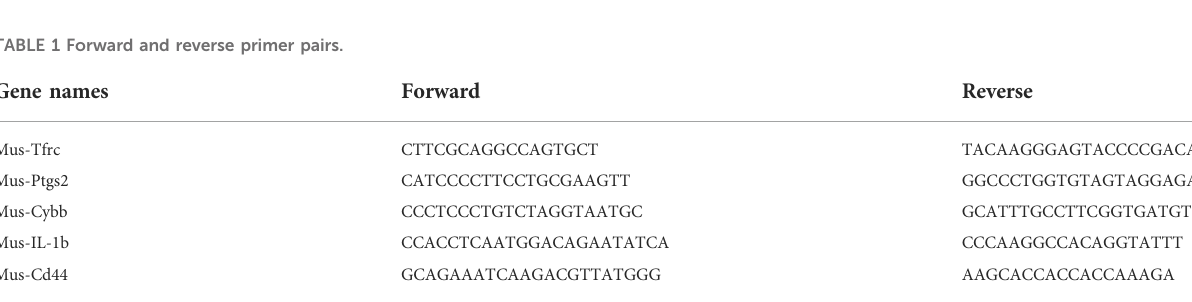
TABLE 1 Forward and reverse primer